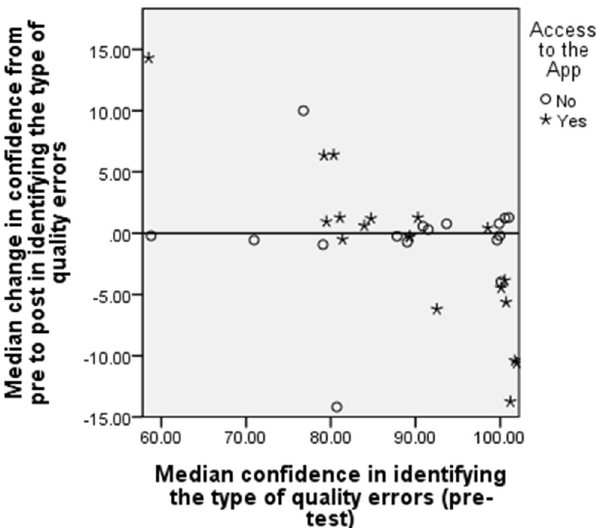
Fig. 5 Scatterplot of median change in confidence level for radiographers in specifying the error-correction strategy of image-quality errors verse pre-test confidence by experimental